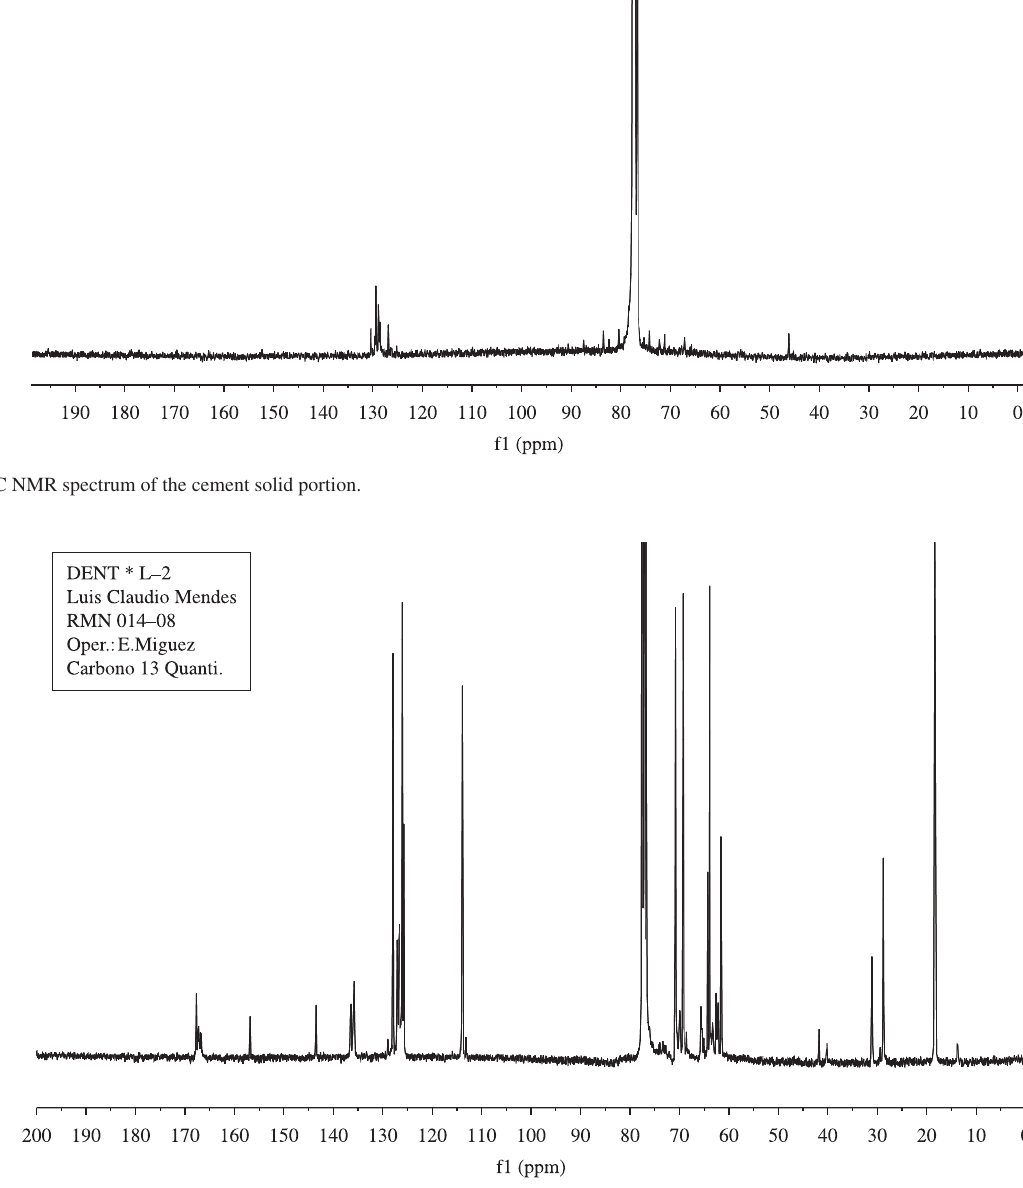
Figure 2. 13 C NMR spectrum of the cement liquid portion.